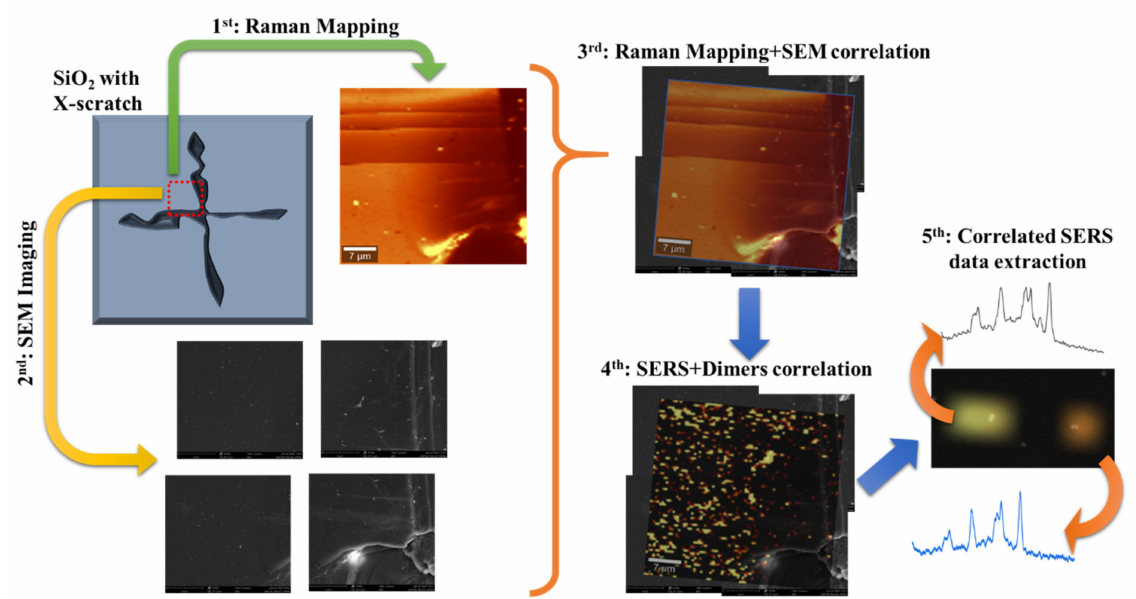
Scheme 1. Schematics showing the correlation procedure as described previously in the methodology. The scratch-marked SiO 2 substrate with the nanostructures is first mapped by Raman and later by SEM, which can be correlated in one image, which later is used to correlate the SERS signals with the dimers distributed in the SiO 2 , the spectra are then collected and